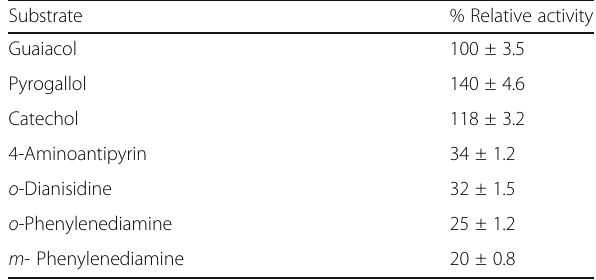
Table 2 Relative activities of ginger PGII towards substrates Substrate % Relative